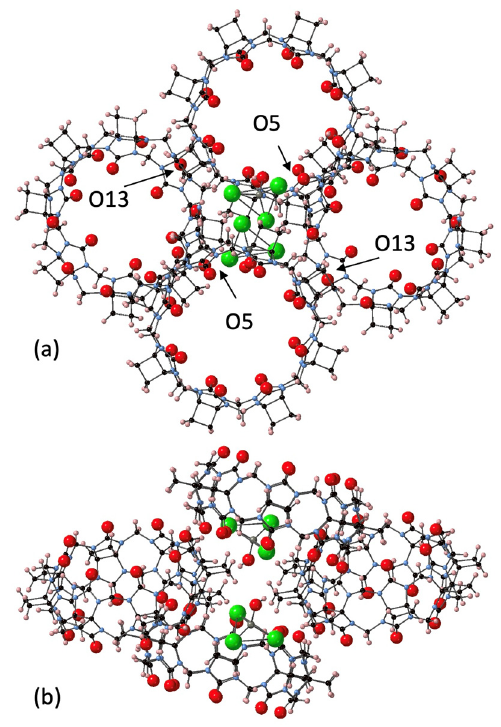
Figure 5. Views of the crystal packing of 4 . The close association of the cyclobutano CH 2 outer surface of CyB 8 Q[8] with the [ZnCl 3 H 2 O] − anion is shown. ( a ) O5 and O13 are labelled and have close interactions with cyclobutano CH 2 . ( b ) The same structural unit with a side view after rotating vertically 90°. All water molecules were omitted for clarity, except Zn-coordinated H 2 O.